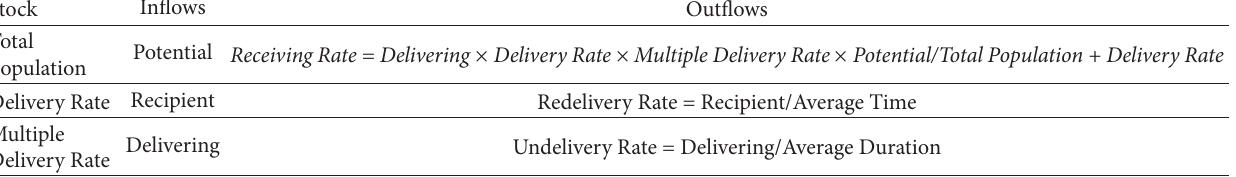
Table 1: Inflows and